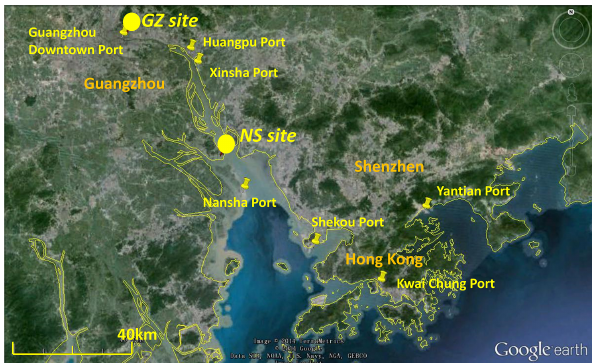
Figure 1. Location of the Guangzhou (GZ) and Nansha (NS) sam- pling